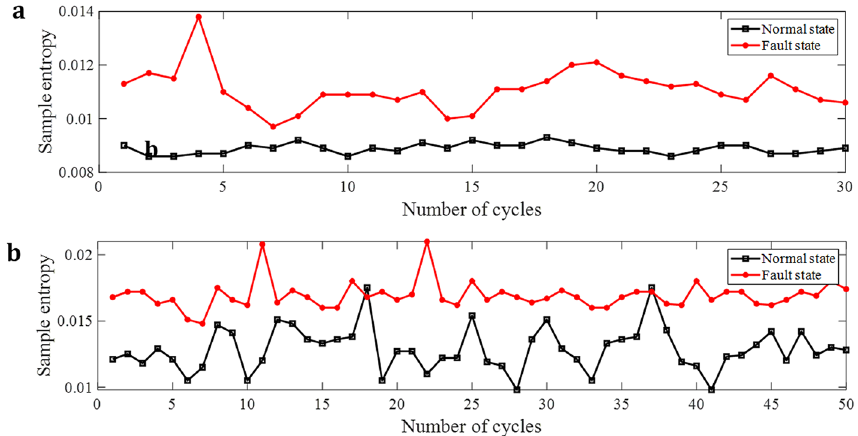
Figure 8. Sample entropy of current in three-phase motor circuit and frequency converter circuit. ( a ) Sample entropy of current in three-phase motor circuit. ( b ) Sample entropy of current in frequency converter